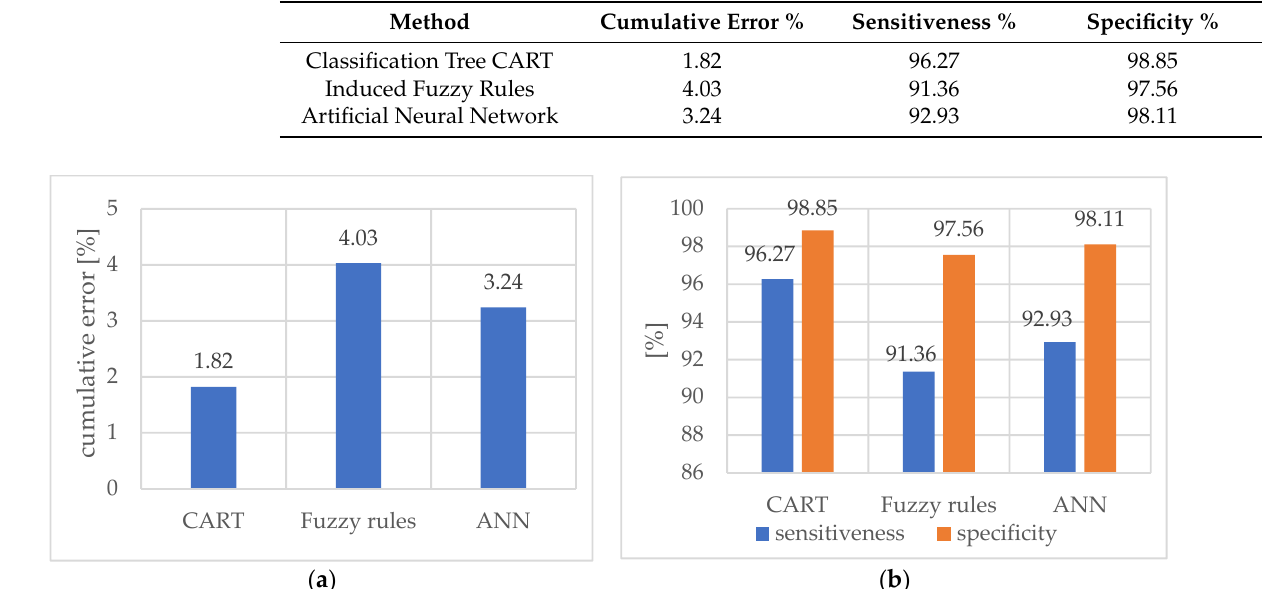
Table 3. Final results of three classification methods (considering the cutting parameter v c ).